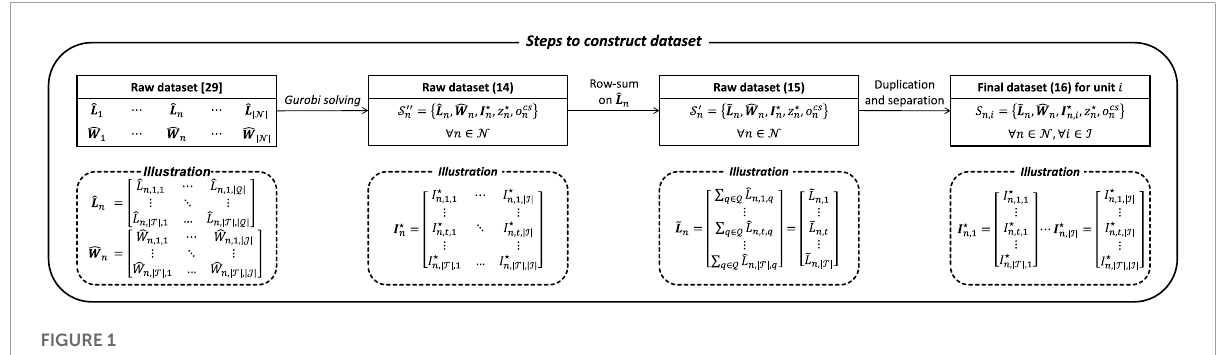
FIGURE 1 Steps to construct